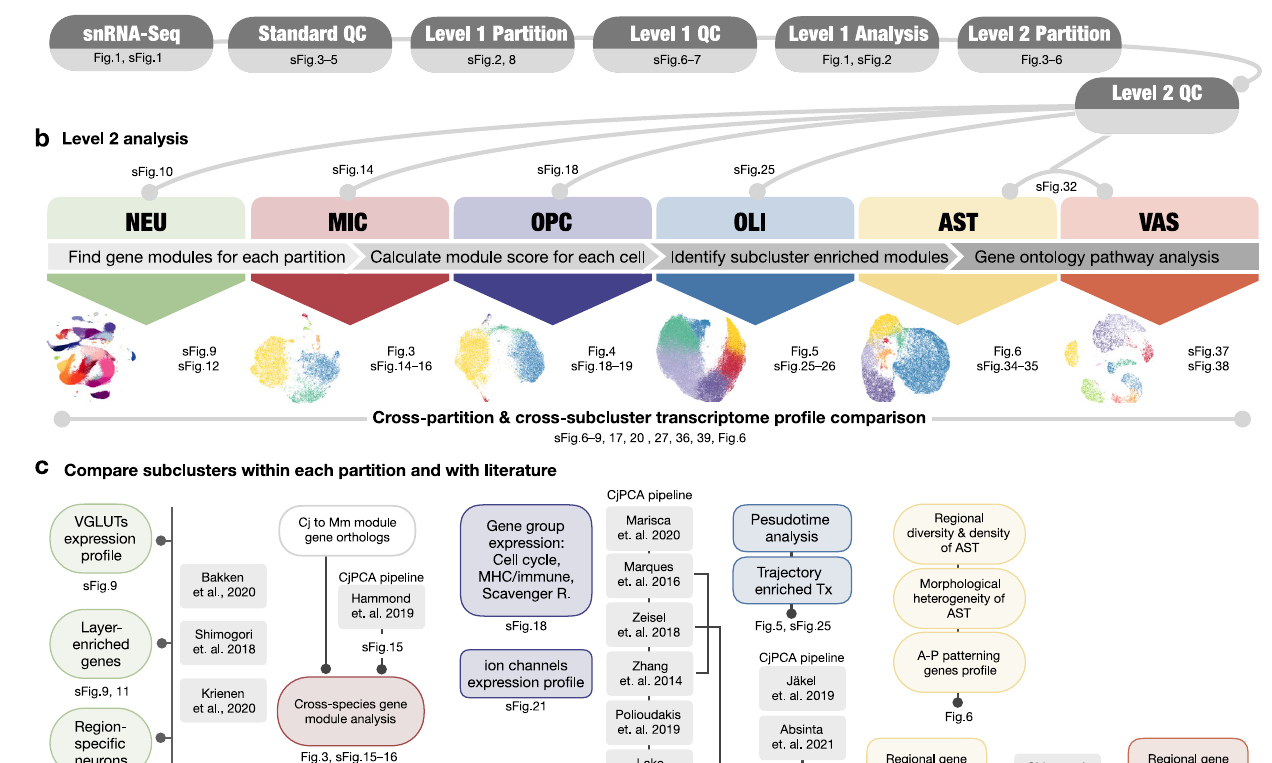
Fig. 2 | Schematic summary of analysis work fl ow with fi gure index. a Data preprocessingstepswithqualitycheckand Level1analysis. b Level2analysisdone on all cell classes, including subclustering, gene module analysis, and gene ontol- ogy pathway analysis. c Level 2 analysis done on individual partitions, focusing on cross-dataset and cross-cluster comparisons. Mm Mus musculus , Hs Homo